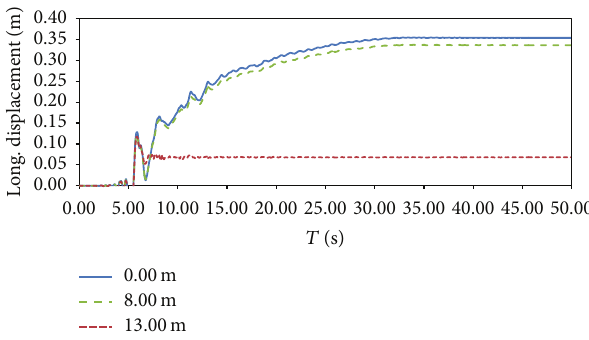
Figure 6: Longitudinal displacement at 13.00 m, 8.00 m, and 0.00 m